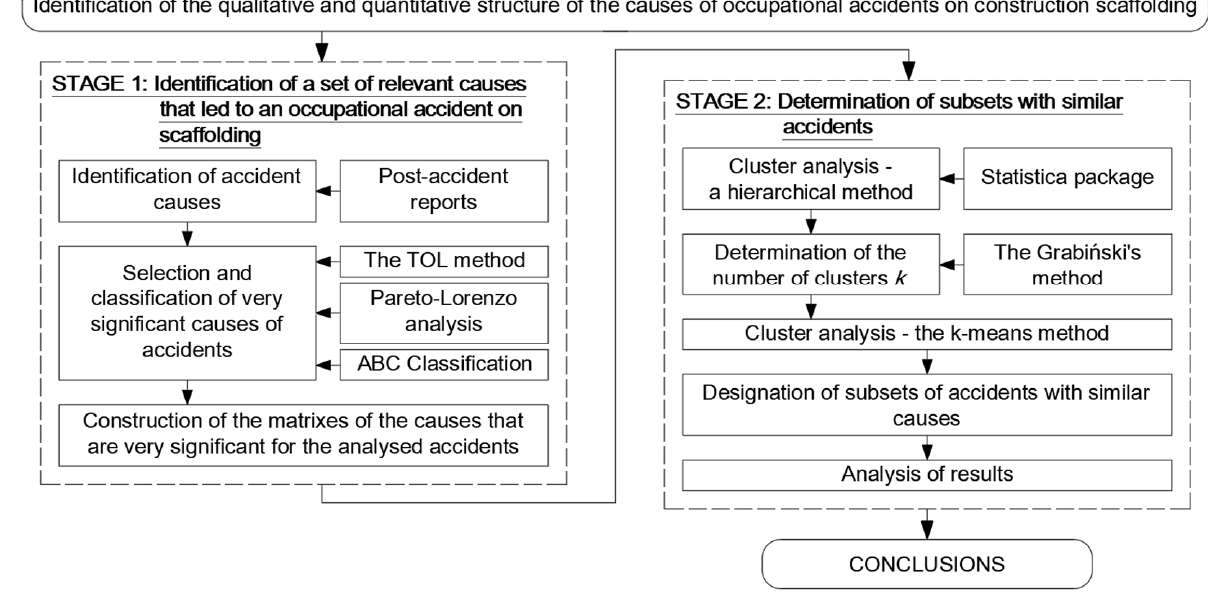
Figure 1. Research methodology diagram.